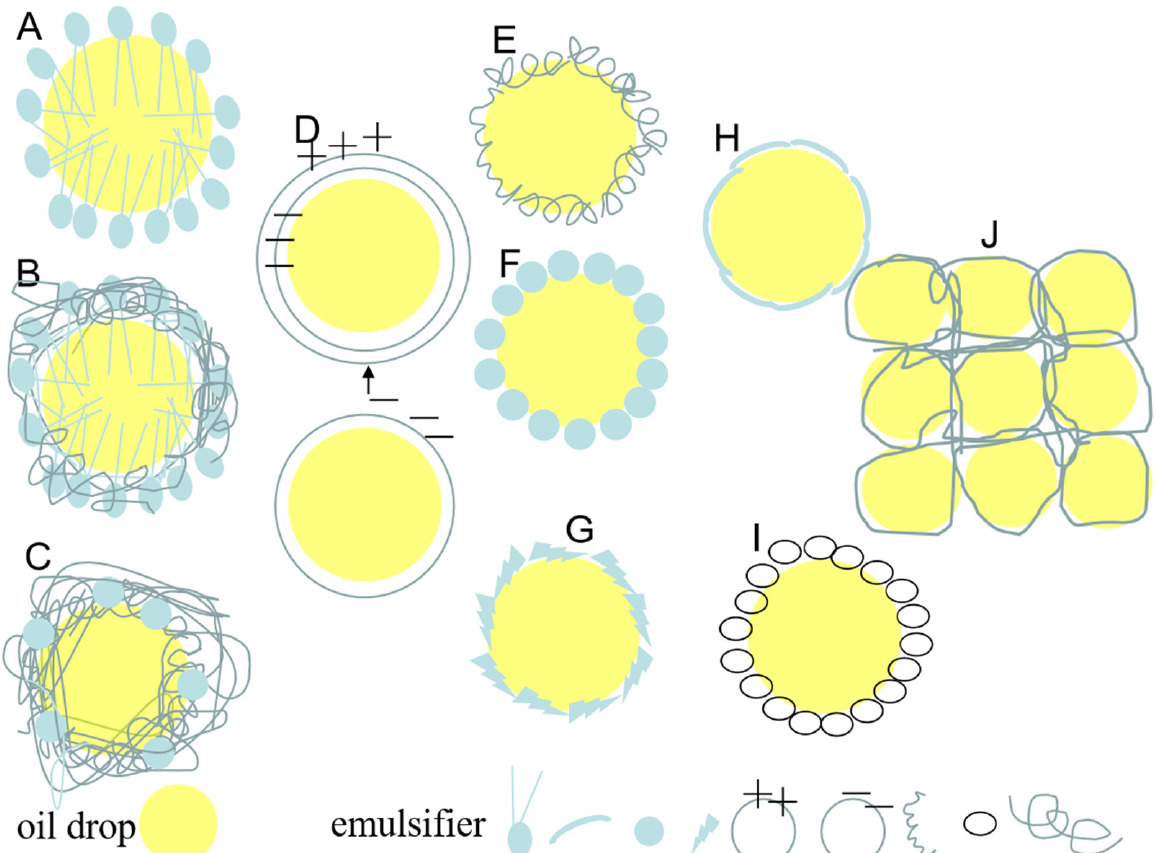
Figure 4. Schematic diagram of emulsifying stabilizer in emulsion: ( A ) surfactant, ( B ) mixed emul- sifier, ( C ) conjugated emulsifier, ( D ) multi-layer emulsifier, ( E ) fibers, ( F ) spherical, ( G ) microgels, ( H ) nanogels fibrils, ( I ) hollow nanoparticles, and ( J ) structural agents.